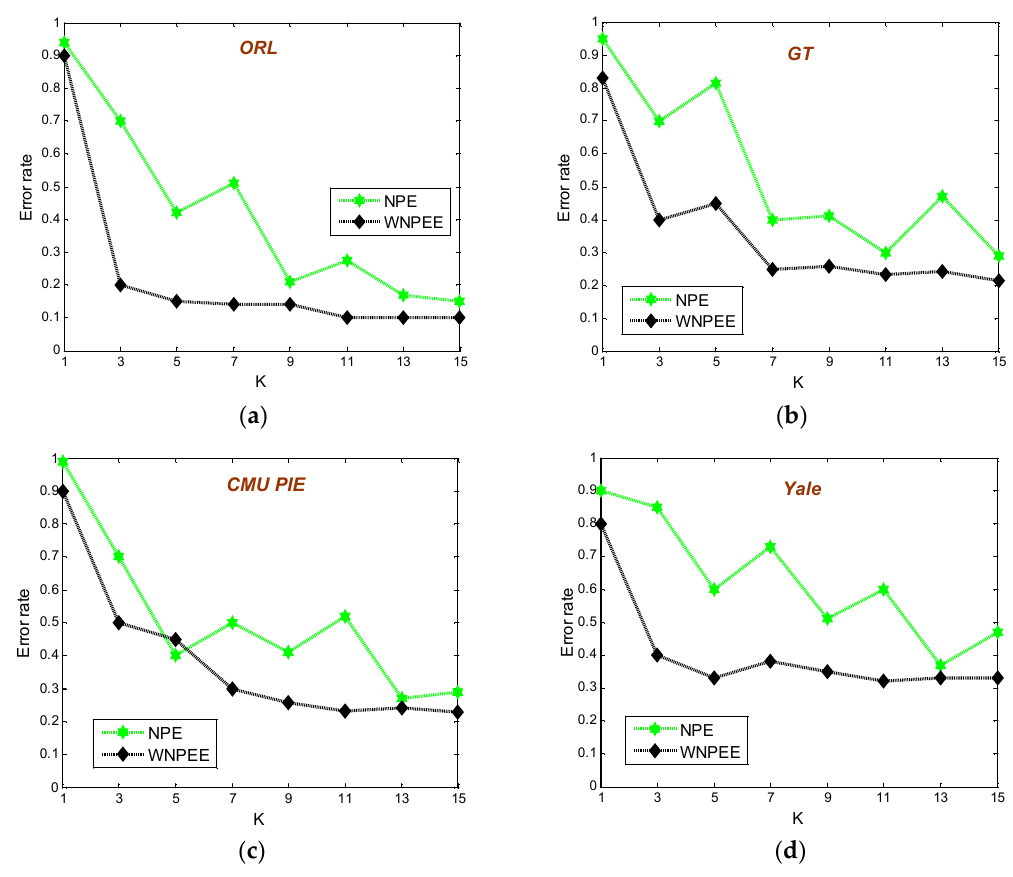
Figure 9. Error rates of NPE and proposed KWNPE corresponding to parameter of neighborhood size